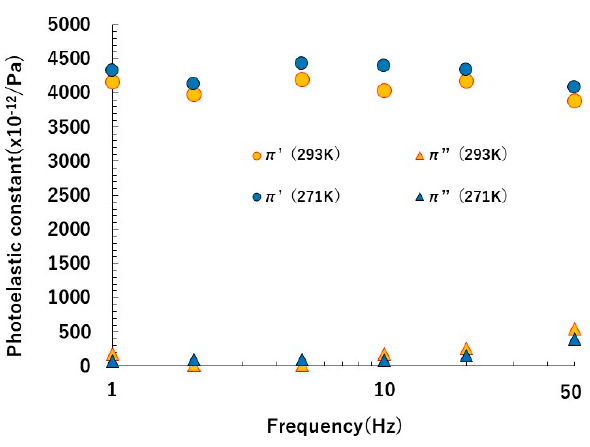
Figure 6. Dynamic photoelasticity measurement results of AR-2.